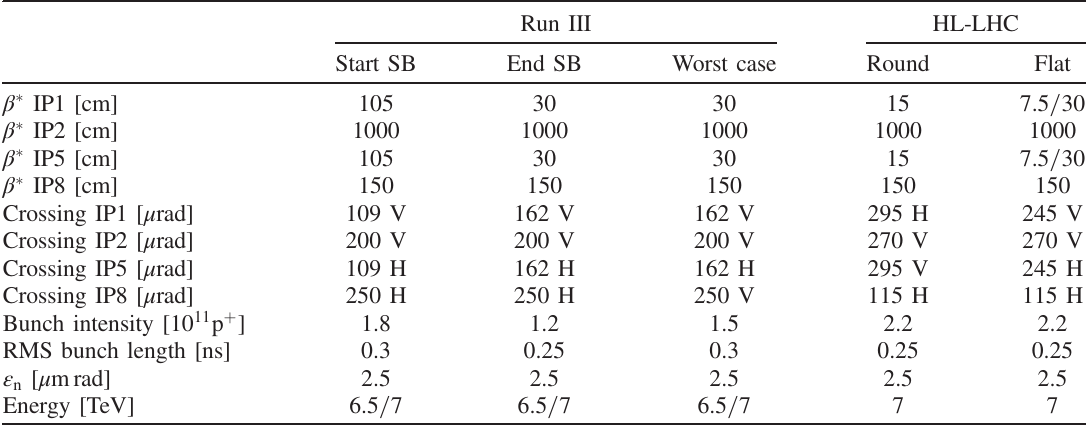
TABLE IV. Comparison of the optics parameters used for Run III [54] and HL-LHC ( HLLHCv1.4 [12]) simulations of the beam-beam kick. The crossing orientations are vertical (V) or horizontal (H).